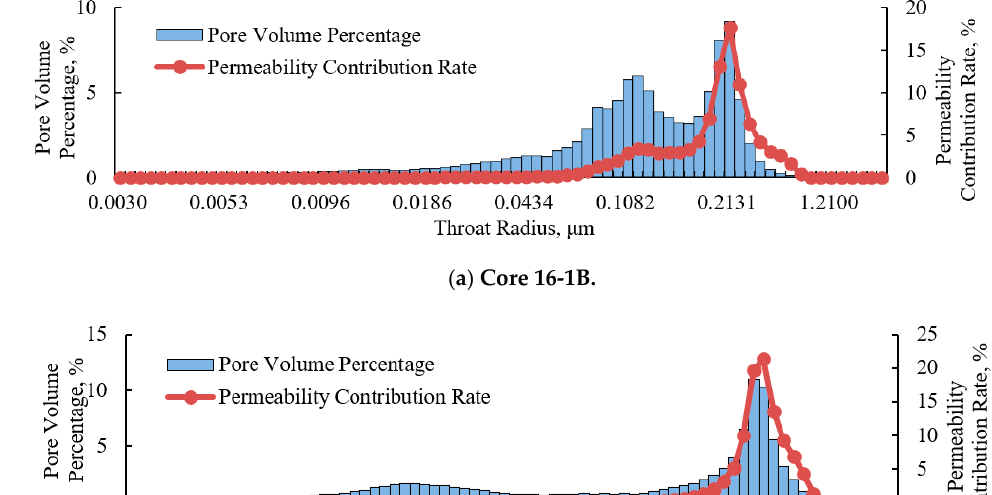
Figure 4. HPMI curves of the three cores.